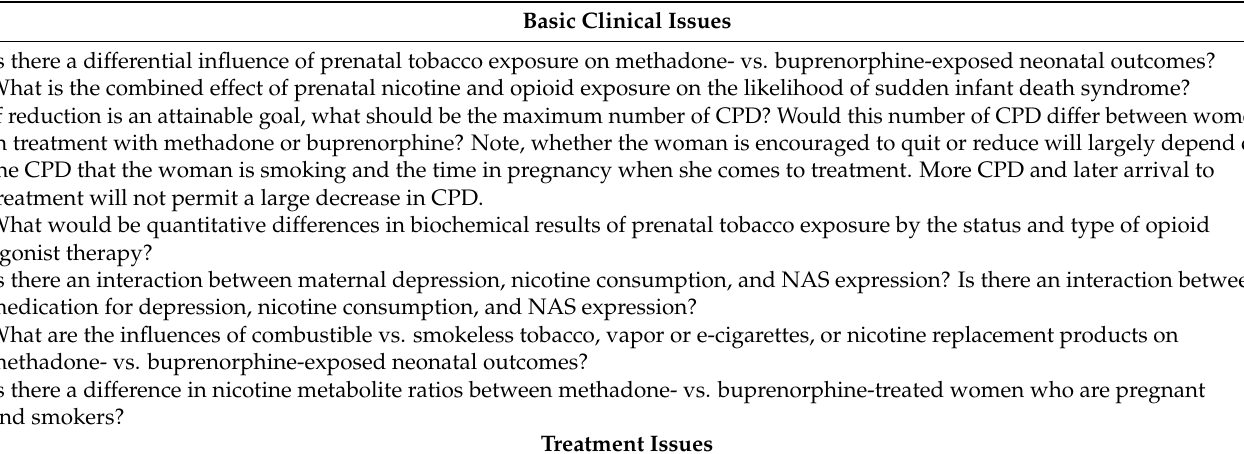
Table 2. List of potential future research investigations.